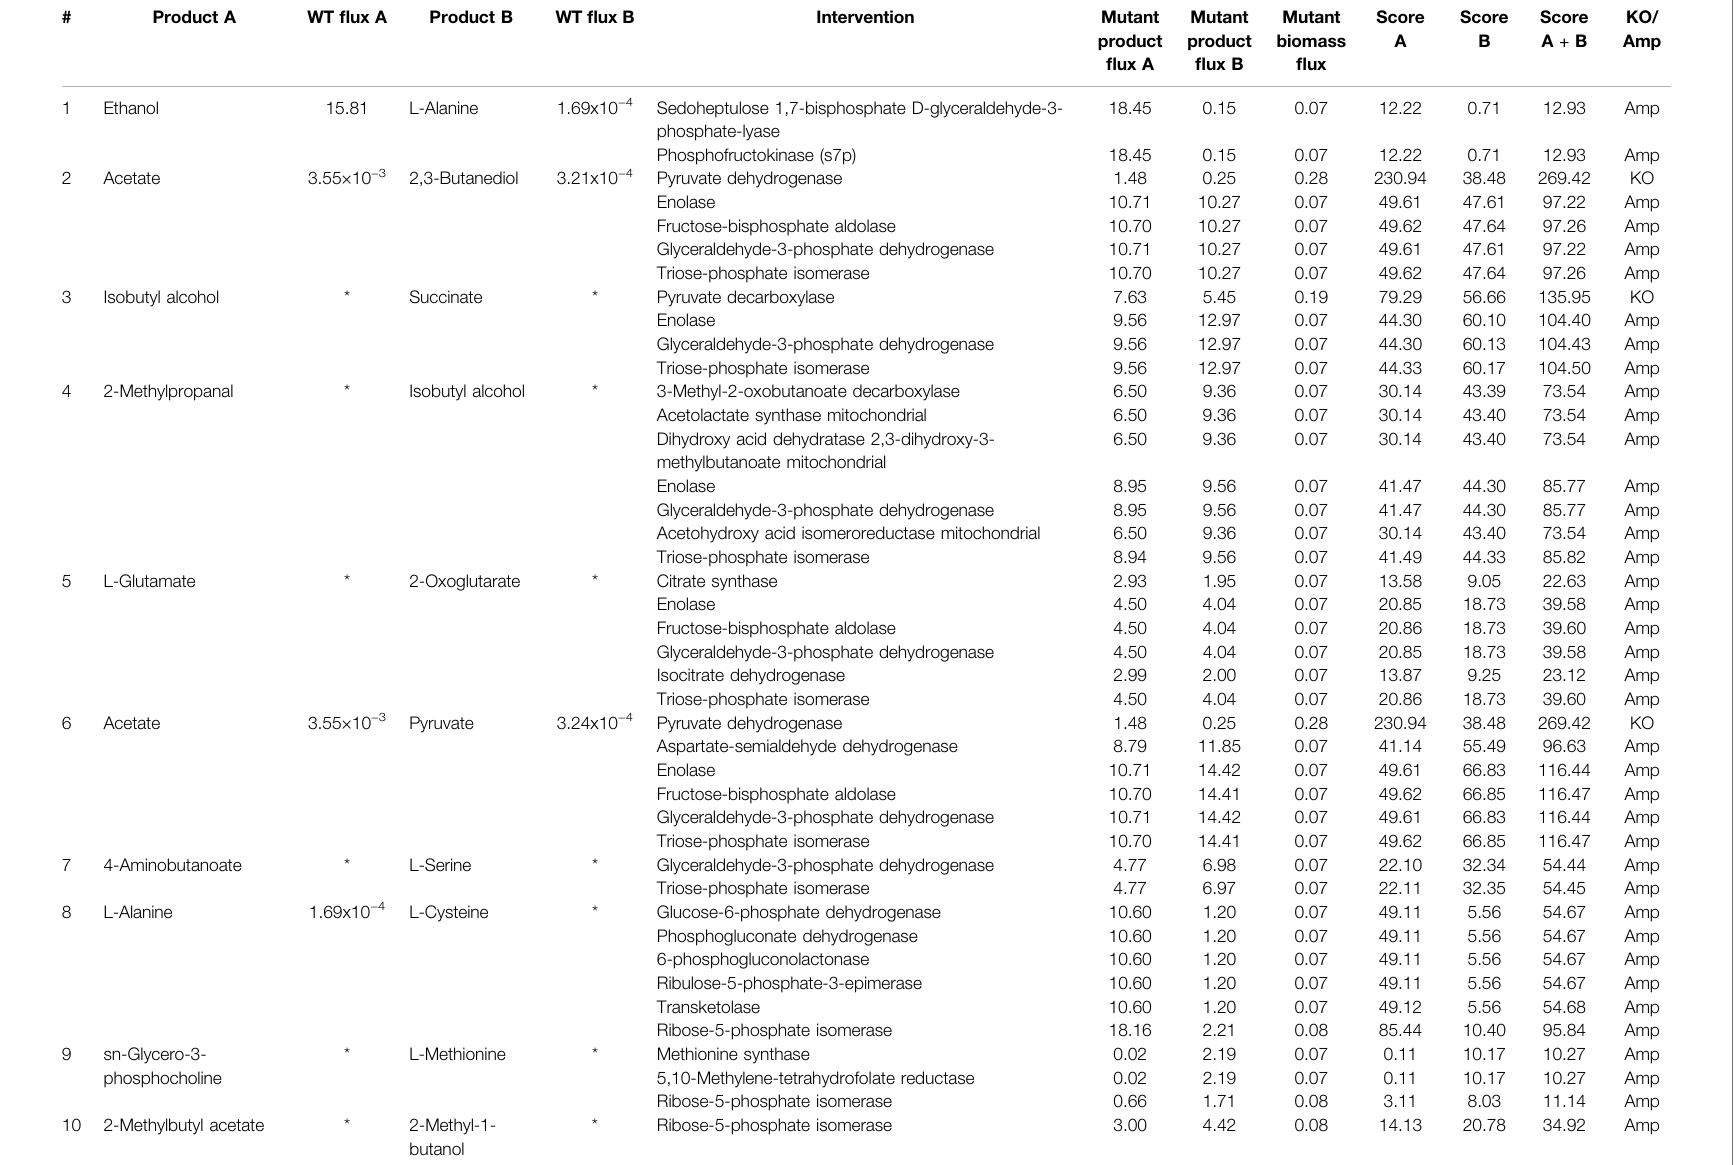
TABLE 3 | Intervention strategies for co-production of pairs of metabolites in S. cerevisiae under aerobic